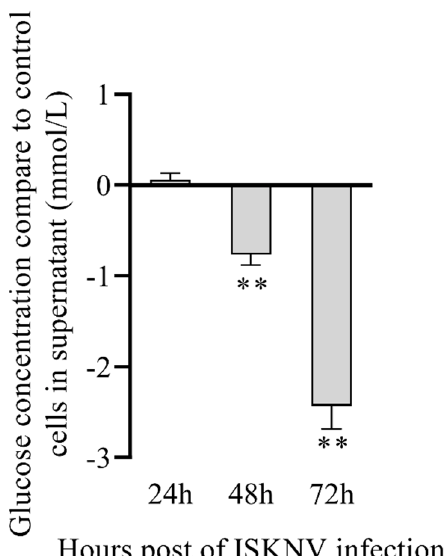
Figure 5. The comparative changes of glucose concentrations in cell culture supernatants of the ISKNV-infected group and the control group. The comparative change between ISKNV-infected cells and control cells is defined as C [glucose concentration in supernatant (ISKNV-infected cells) ] − C [glucose concentration in supernatant (control cells) ].